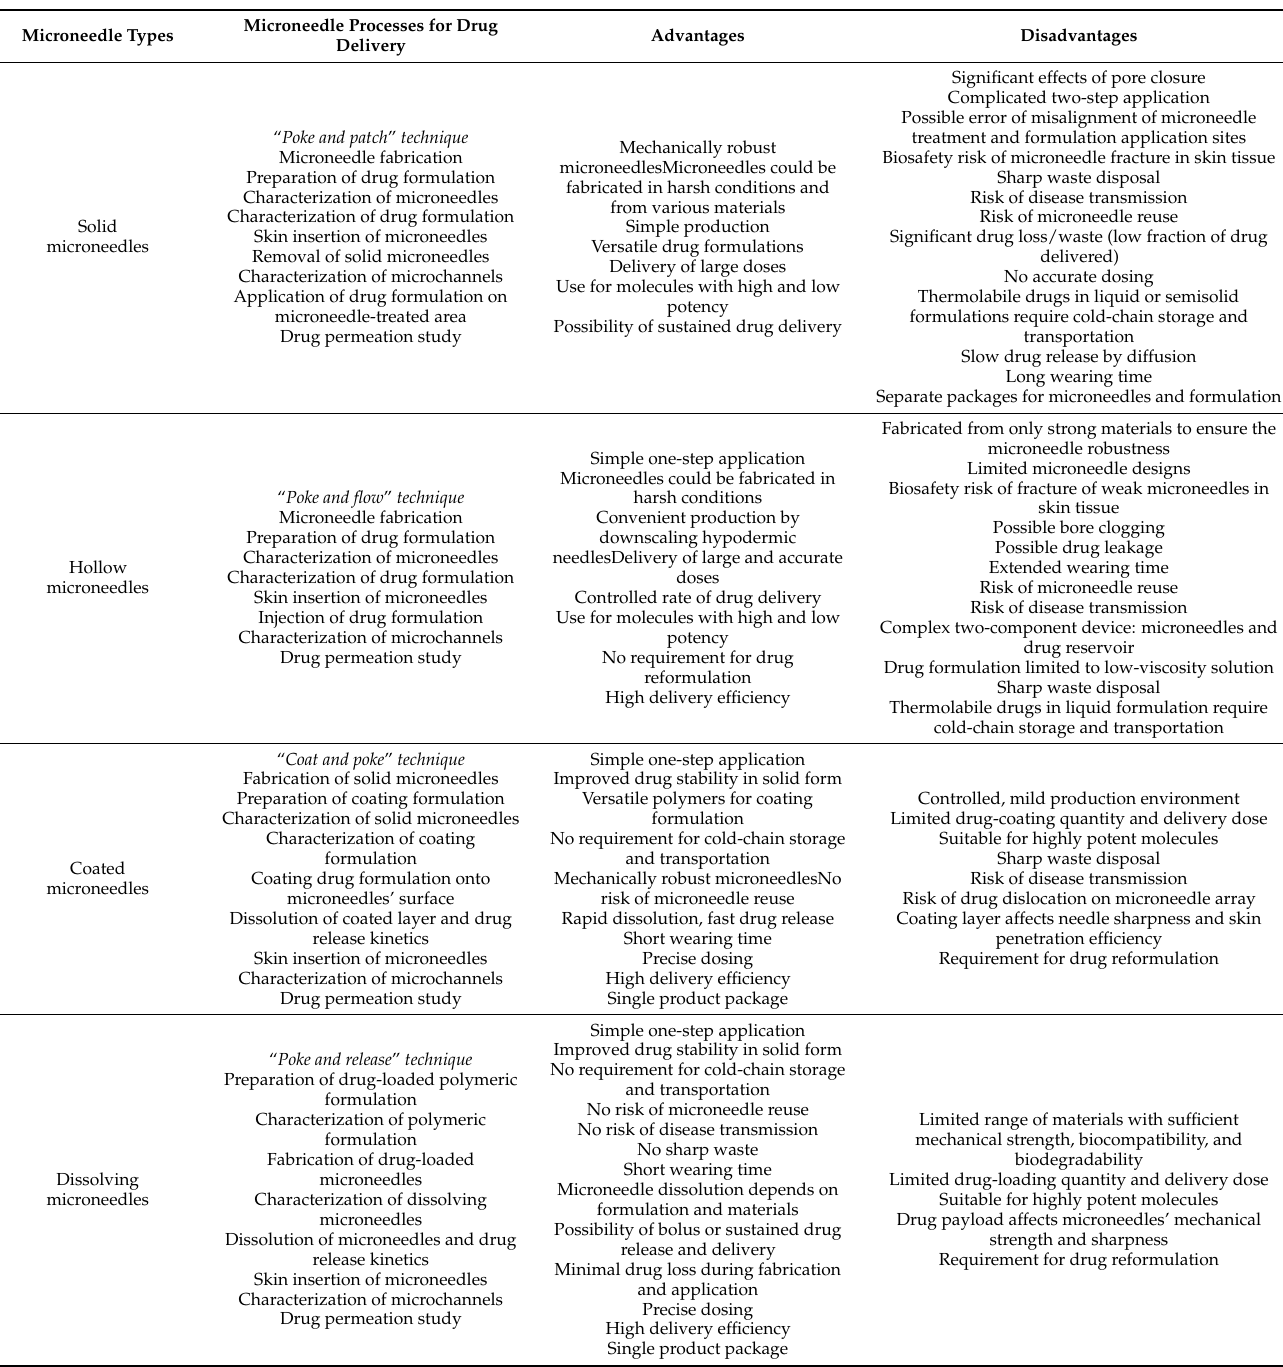
Table 2. Microneedle types for transdermal drug